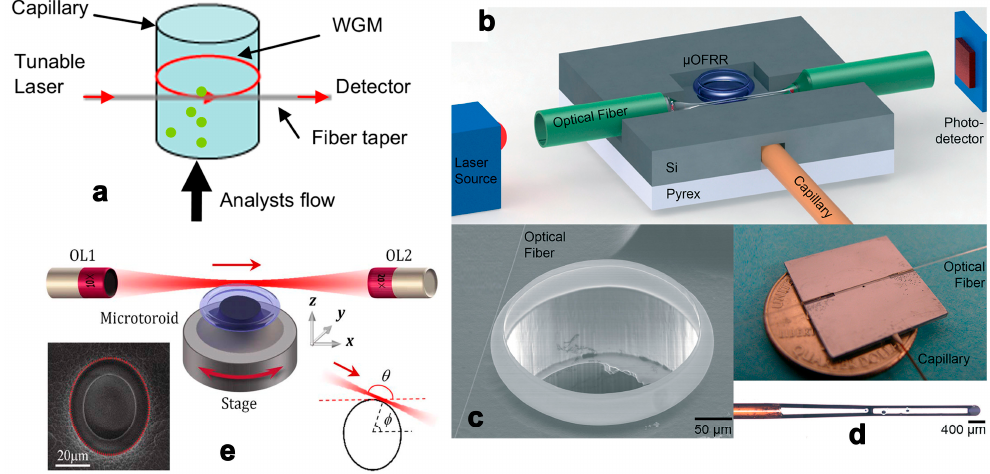
Figure 4. ( a ) The optofluidic ring resonator based on thin ‐ walled capillary. Reprinted with permission from [42]. Copyright (2014) Elsevier; Schematic diagram ( b ), SEM image ( c ) and photograph ( d ) of the µ OFRR sensor. Reprinted with permission from [43]. Copyright (2014) RSC; ( e ) Schematic diagram of the experimental setup for free ‐ space coupling between a laser beam and a deformed toroidal microcavity. Reprinted with permission from [44]. Copyright (2016) OSA.